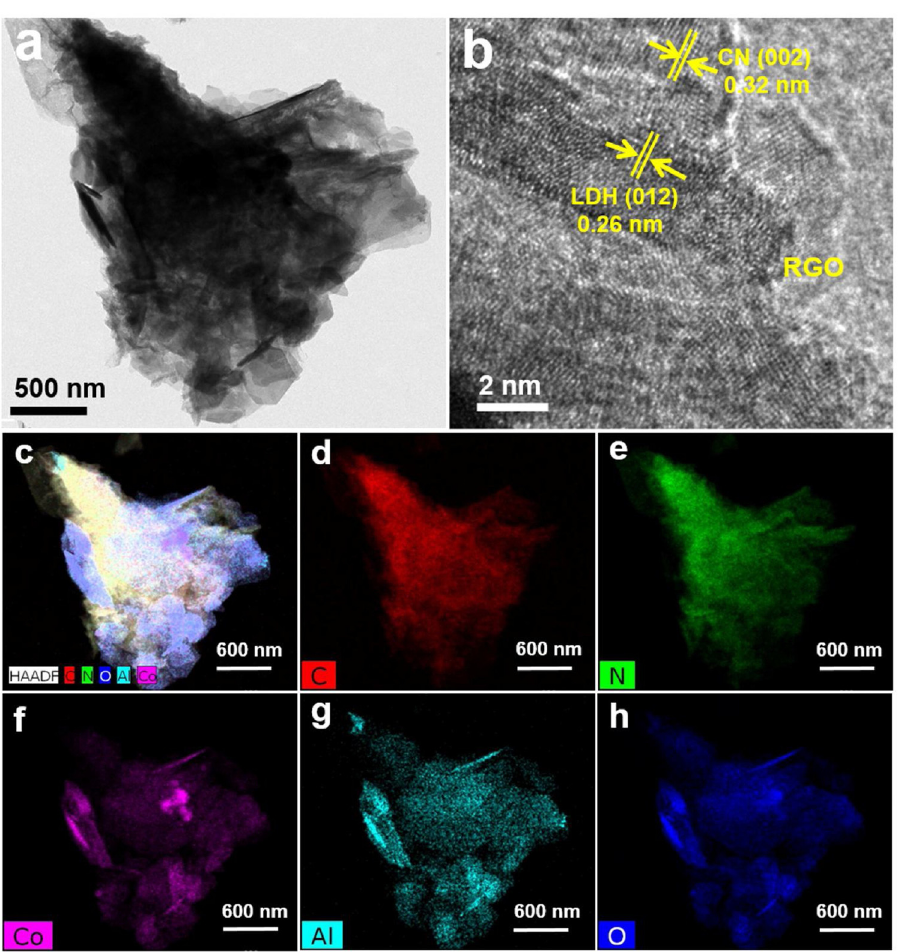
Figure 10: TEM ( a ) and HRTEM ( b ) images of the LCR - 15 photocatalyst. EDS elemental mappings of constituent elements in the LCR - 15 photocatalyst ( c – h ) . Reproduced with permission from ref. [ 94 ] ; copyright ( 2019 ) ,